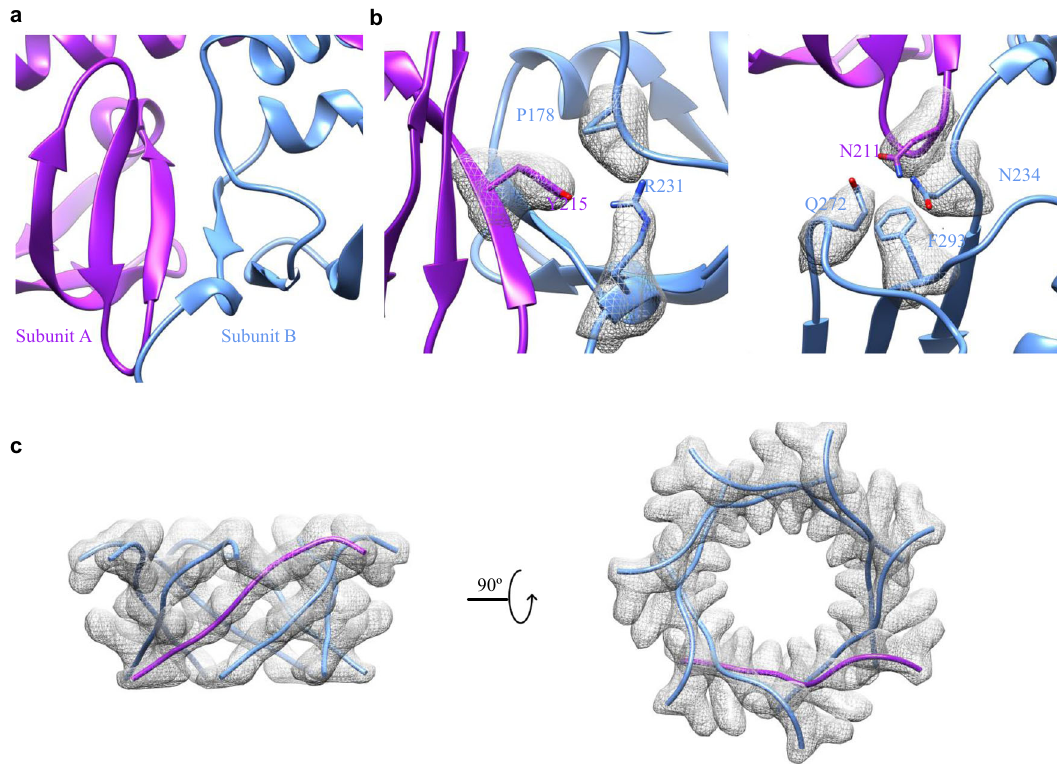
Fig. 5 Interactions responsible for the heptameric assembly. a β strands from neighboring β domains interact with each other in an antiparallel fashion. This view is the same view as the β domain shown in Fig. 1a. b speci fi c residues in the interfaces between the β domain and its neighboring β / αβ domains. c β -barrel like C-terminal